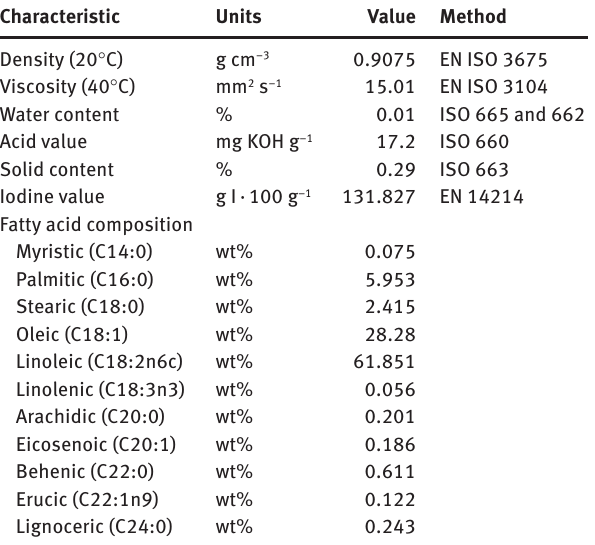
Table 1: Physical and chemical properties of the oil used in the